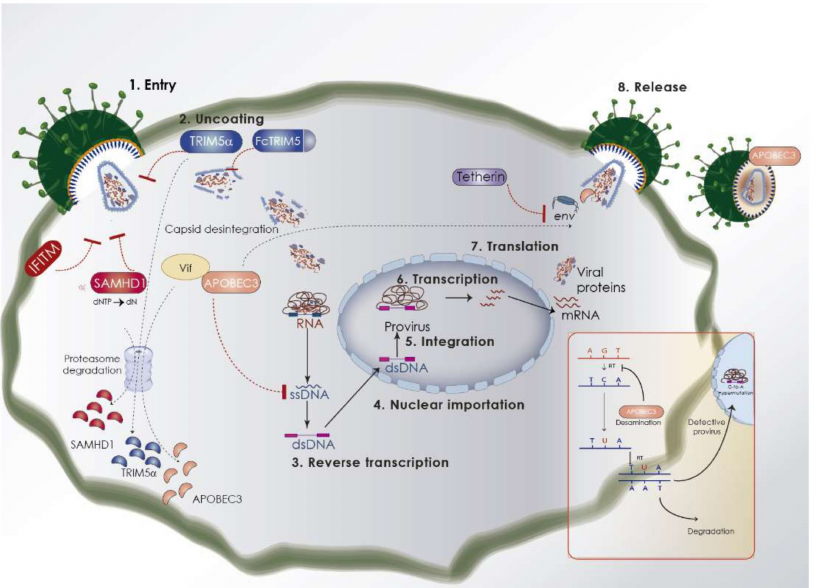
Figure 3. Overview of the lentivirus replication cycle and cellular restriction factors that target lentiviruses and their viral antagonists. The key mechanisms by which restriction factors directly act upon the retroviral replication cycle, and their counteraction by viral accessory proteins, are depicted. Virus replication steps are shown with numbers. After entry, TRIM5 α recognizes viral capsid and induces premature decapsidation and autoubiquitination, except in the case of Felis catus . Other measures that may inhibit the infection cycle at this stage are SAMHD1 and IFITM (interferon-induced transmembrane protein 3). Viral Vif can counteract some of these mechanisms by inducing proteasome-associated degradation. APOBEC3, which is harbored in viral particles, mediates hypermutation of the viral genome, as indicated in the inset panel. When the lentiviral genome and proteins are assembling, tetherin can trap new virions and reduce